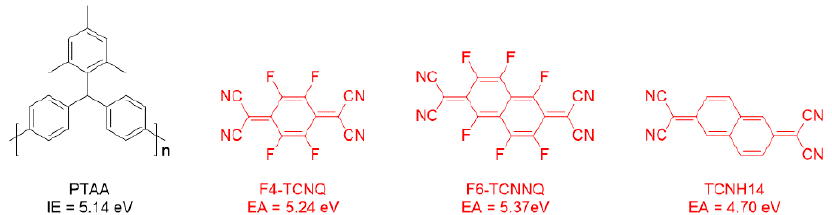
Figure 1. Chemical structures of the compounds used in the doped hole transporting layer (HTL). Ionization energy (IE) of poly[bis(4-phenyl)(2,4,6-trimethylphenyl)amine] (PTAA) and the elec- tron affinity (EA) of each dopant, i.e., 2,3,5,6-tetrafluoro-7,7,8,8-tetracyanoquinodimethane (F4- TCNQ), 1,3,4,5,7,8-hexafluoro-11,11,12,12-tetracyanonaphtho-2,6-quinodimethane (F6-TCNNQ), and